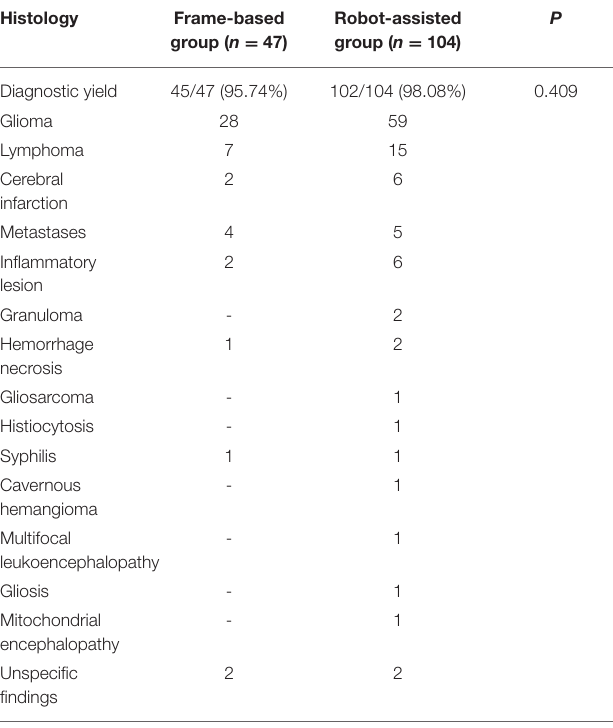
TABLE 3 | Histologic diagnosis in 151 stereotactic